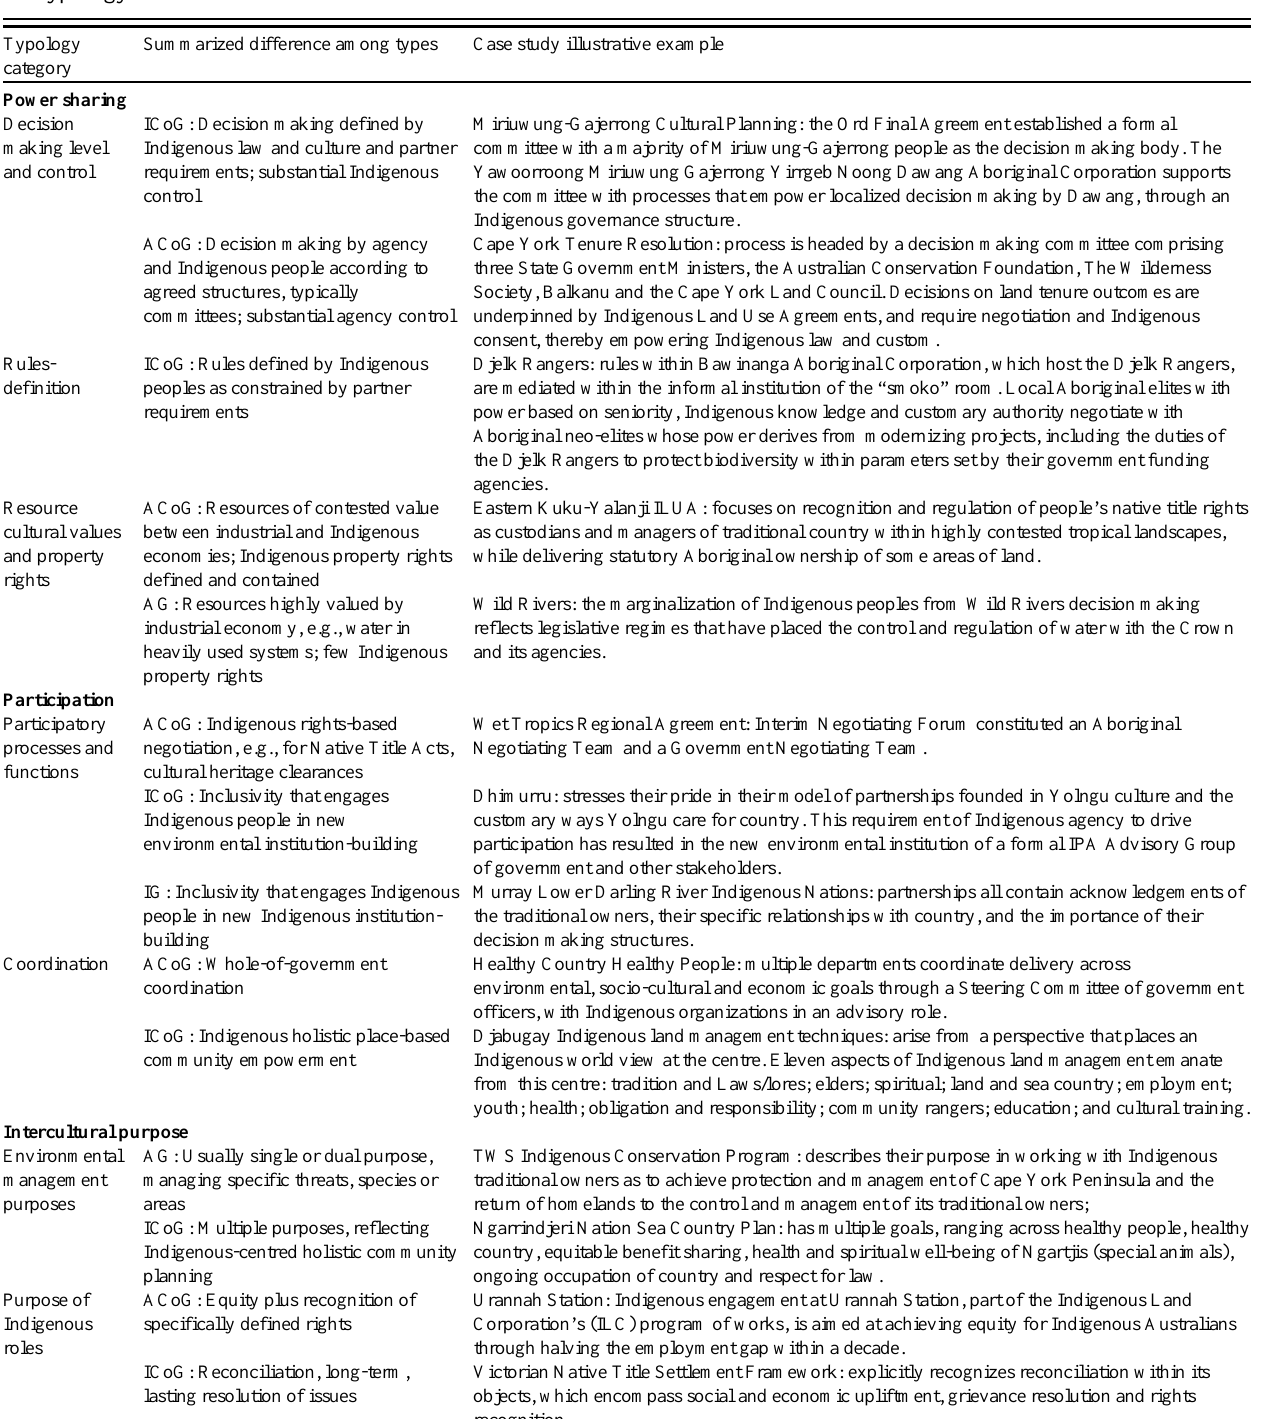
Table 3 . Illustrative examples of the summarized differences among the case studies according to the categories of analysis for the typology Typology